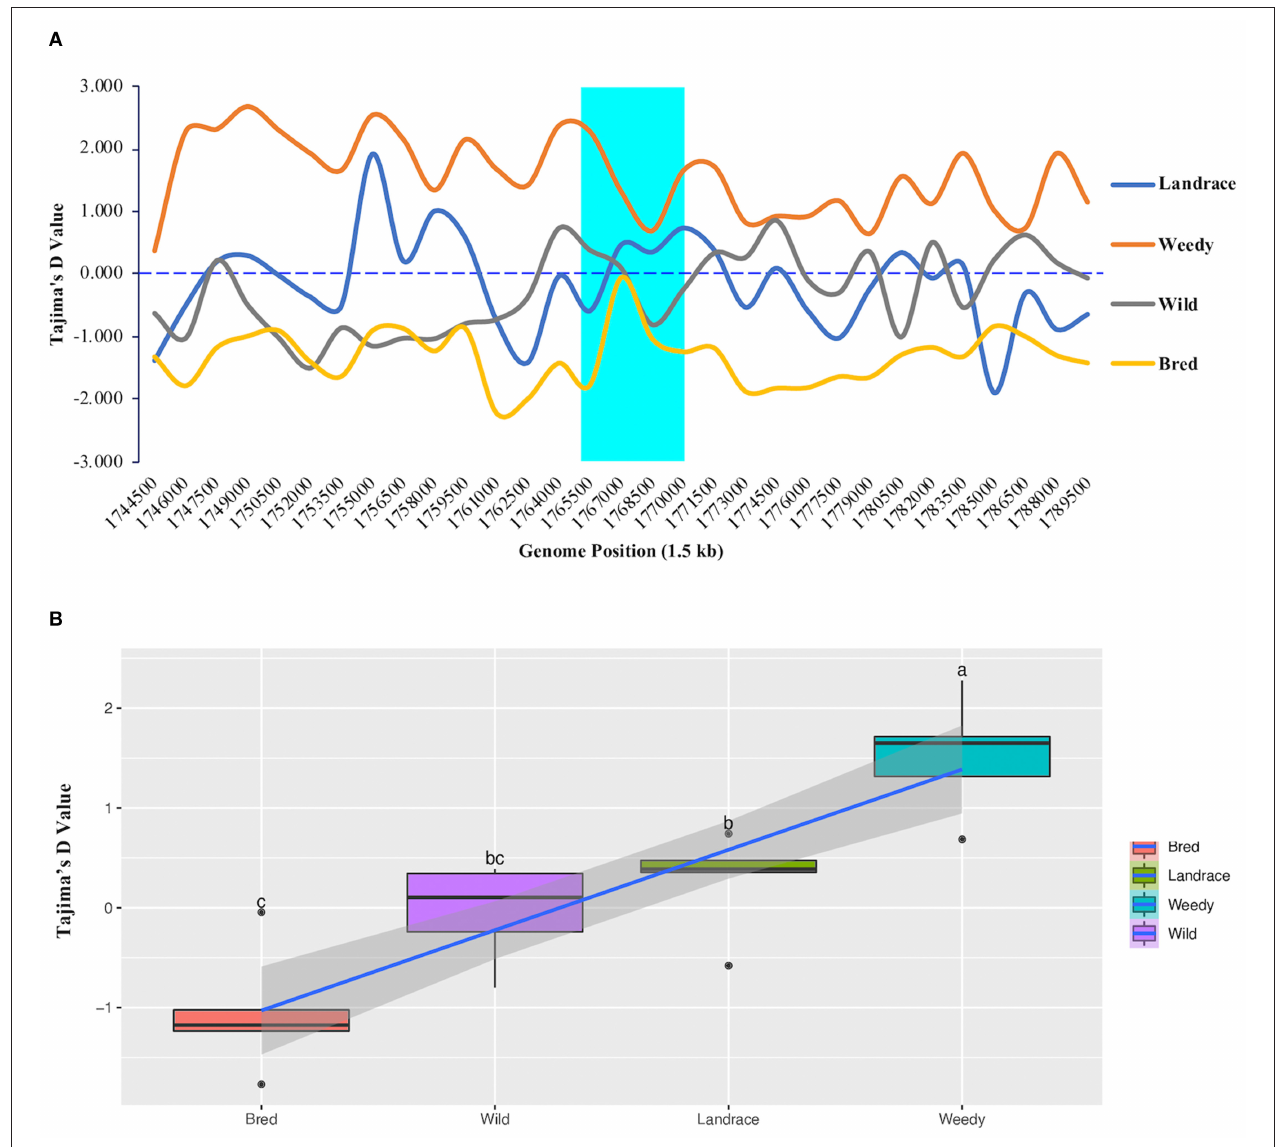
FIGURE 4 | Tajima’s D values of GBSSI ( Os06g0133000 ) in 475 accessions of the Korean rice collection by means of variety types (landrace, weedy, bred, and wild). (A) Tajima’s D values representing different individual segregating sites in 1.5 sliding windows of the GBSSI gene region. Cyan indicates the GBSSI gene region, and each colored line represents a different rice variety type. (B) Box plots represent different distribution patterns of GBSSI genetic variations according to Tajima’s D values among the variety